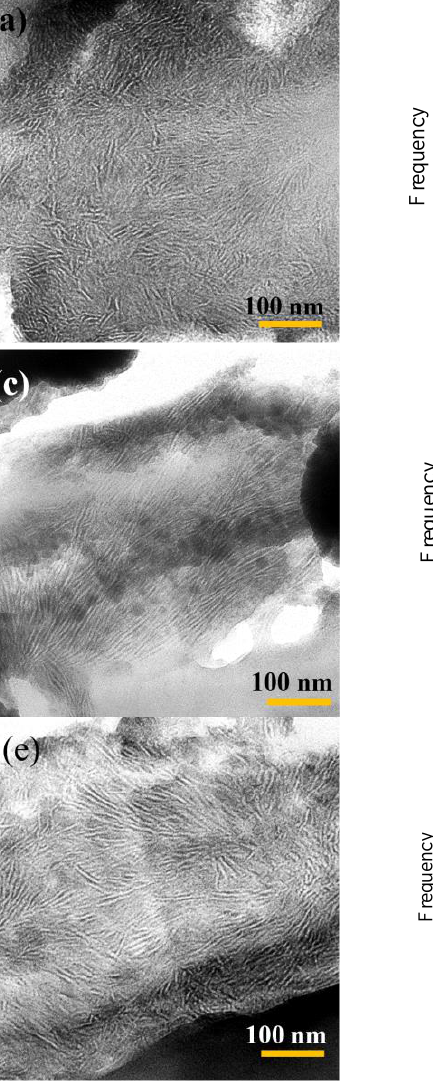
Figure 8. TEM micrographs of RuO 4 -stained PET samples: ( a ) virgin PET, ( c ) r-PET, and ( e ) REX-r-PET samples. Frequency distribution of lamellar thickness for ( b ) virgin PET, ( d ) r-PET, and ( f ) REX-r-PET.